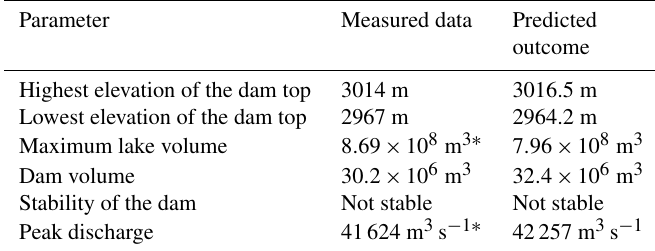
Table 3. Comparison of the measured data and the predicted results. As measures were taken to reduce the maximum volume of the barrier lake, asterisks indicate estimated results from Chen’s detailed back analyses (Chen et al., 2020).